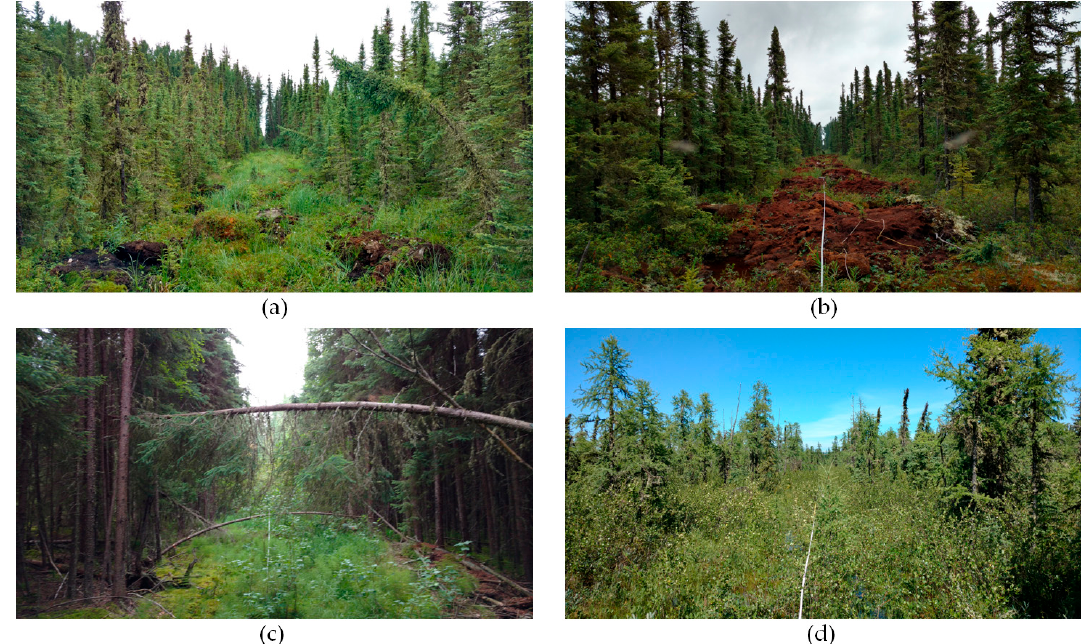
Figure 1. Examples of seismic lines in northern Alberta, Canada: ( a ) treated (mounding and planting) poor fen; ( b ) treated (mounding and planting) bog; ( c ) untreated poor mesic forest; and, ( d ) untreated rich fen. All photographs by Angelo T. Filicetti.